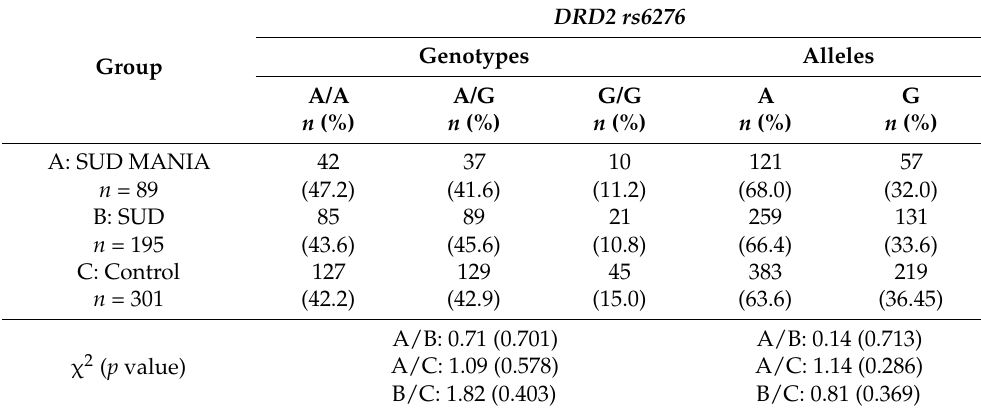
Table 3. Frequency of genotypes of the DRD2 rs6276 gene polymorphisms estimated in SUD patients with mania SUD MANIA, patients with only SUD and without mania, and healthy controls.